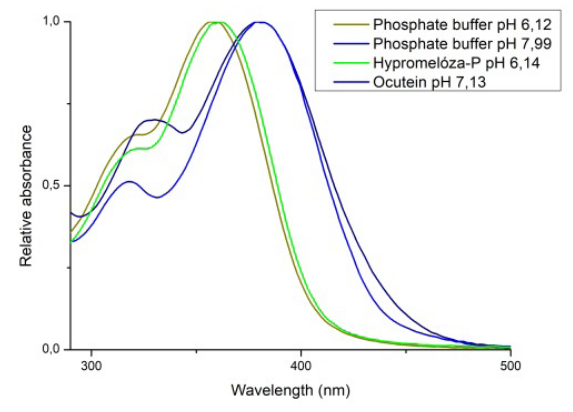
Figure 5: Fisetin pH-dependent spectral changes. Comparison of fisetin spectra in phosphate buffers pH 6.12, 7.99, Hypromelóza-P and Ocutein. For pH-dependent spectral changes observations, 200 mM phosphate buffers with pH 6.12 and 7.99 were used. Fisetin absorption spectra in phosphate buffer pH 6.12 and 7.99 shifted to the wavelength of Hypromelóza-P 6.14 and Ocutein 7.13, respectively.